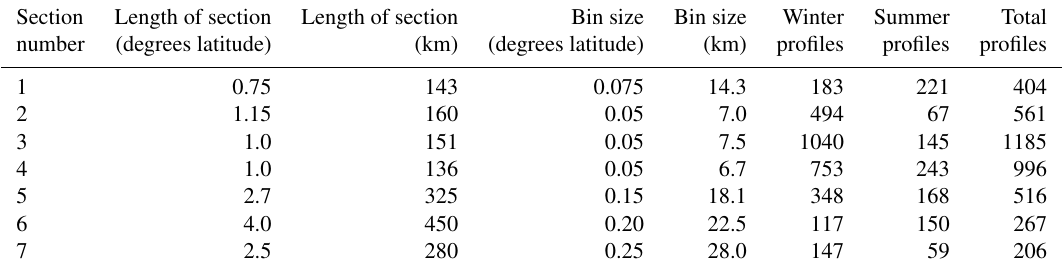
Table 1. Length of section (degrees latitude; kilometers), number of winter (April–September), summer (October–March), total profiles, and the averaging length (degrees latitude; kilometers) for each of the seven hydrographic sections shown in Fig. 3.